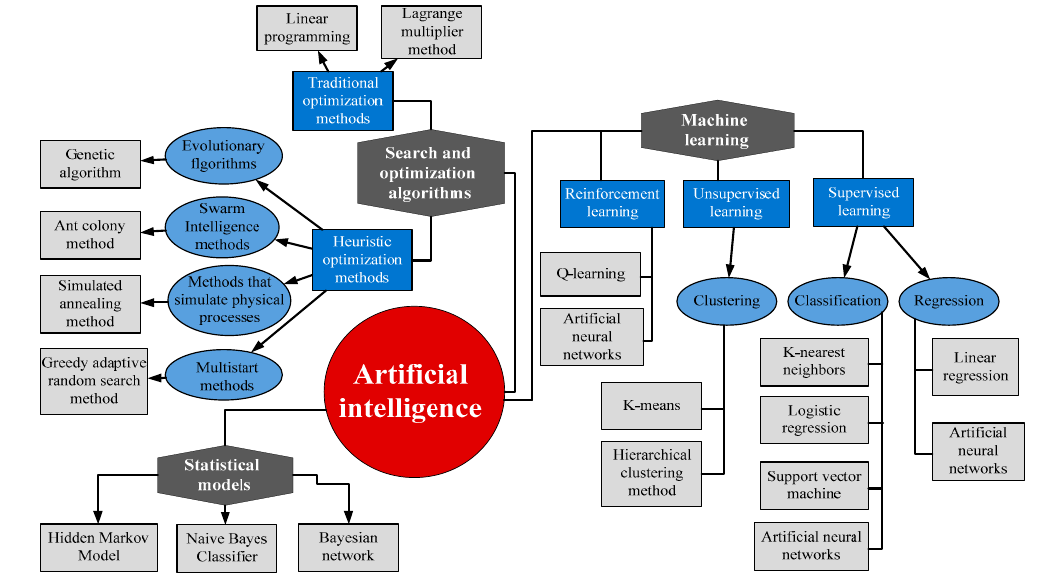
Figure 1. The main directions and methods of artificial intelligence.